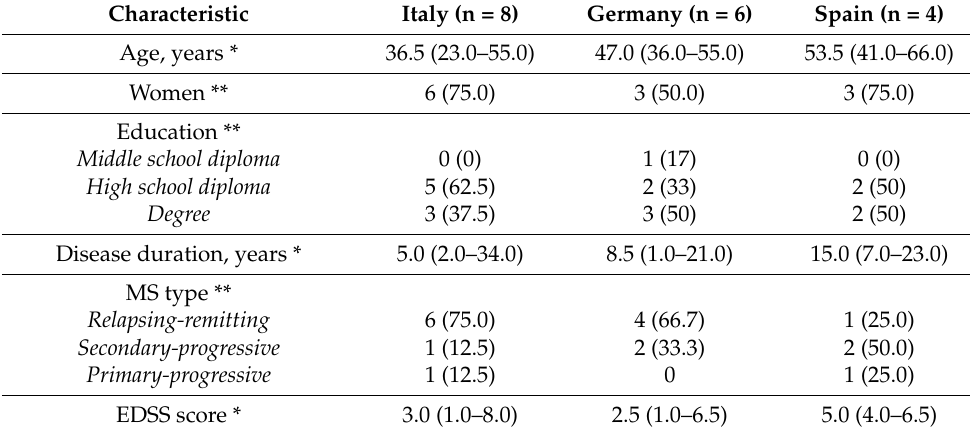
Table 3. Clinical and demographic data of the people with multiple sclerosis who participated in the cognitive